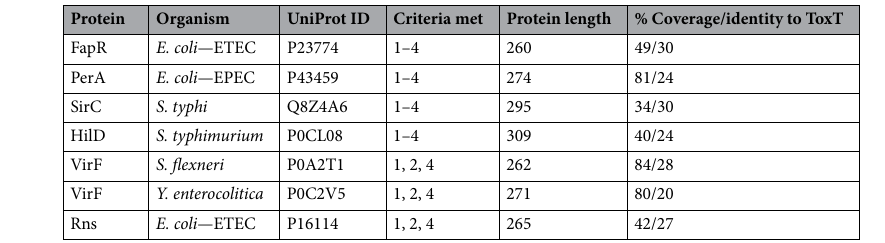
Table 1. List of potential ToxT like AraC